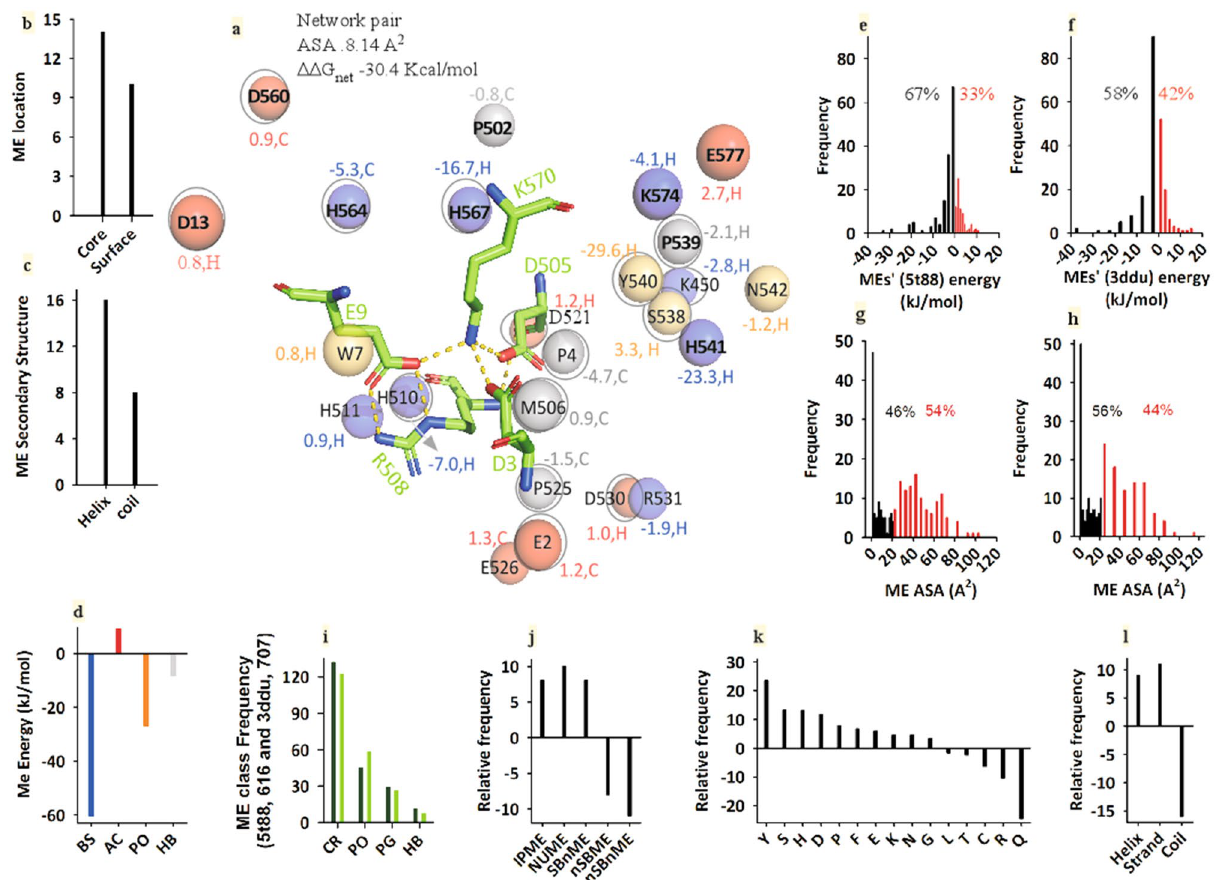
Figure 3. 5t88 than 3ddu’s microenvironment of salt-bridge, its residue-class, distribution, and binary details are more promising. Typical ME ( a , residues: acidic, red; basic, blue; polar, yellow; hydrophobic, grey; core residues are with a sphere with a ring; interaction-energy is shown in the same color of residue with secondary structure i.e. H, helix; C, coil) of a salt-bridge and its location ( b ), secondary structure ( c ) and interaction energy ( d ). The ME is present with the NU unit (ASAav 8.14 Å 2 and net stability − 30.4 kcal/mol). Distribution of 5t88 ( e ) and 3ddu’s ( f ) stable (black) and unstable (red) ME-population (IP & NU population together). Similarly, the distribution of 5t88 ( g ) and 3ddu’s ( h ) buried (black) and exposed (red) ME-population (IP & NU population together). Normalized frequency of residue classes (charged, CR; polar PO; Pro and Glu PG and hydrophobic, HB) of 5t88 (black bar) and 3ddu’s (green bar) ME-population ( i ). Relative frequency of charged ME-residues in 5t88 relative to 3ddu ( j ). IPME ME-residues that act as the microenvironment of the IP only, NUME ME-residues that act as the microenvironment of the NU only, SBnME SB-residues that do not act as the microenvironment, nSBME ME-residues that act as the microenvironment but not participate in salt-bridge and charged-residues that neither participate in the microenvironment nor the salt-bridge formation. Relative frequency of 5t88’s ME-residues relative to 3ddu ( k ). Relative preference to the secondary structure of 5t88’s ME-residues relative to 3ddu ( l